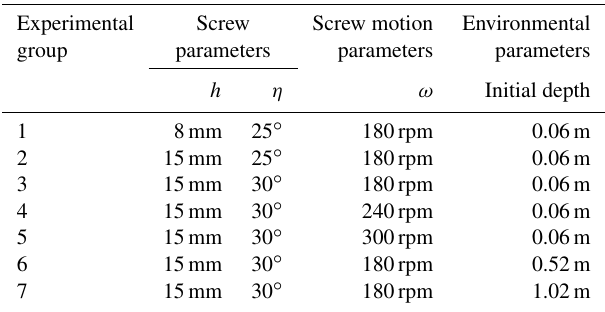
Table 4. Simulation experiment arrangement of single factor change.